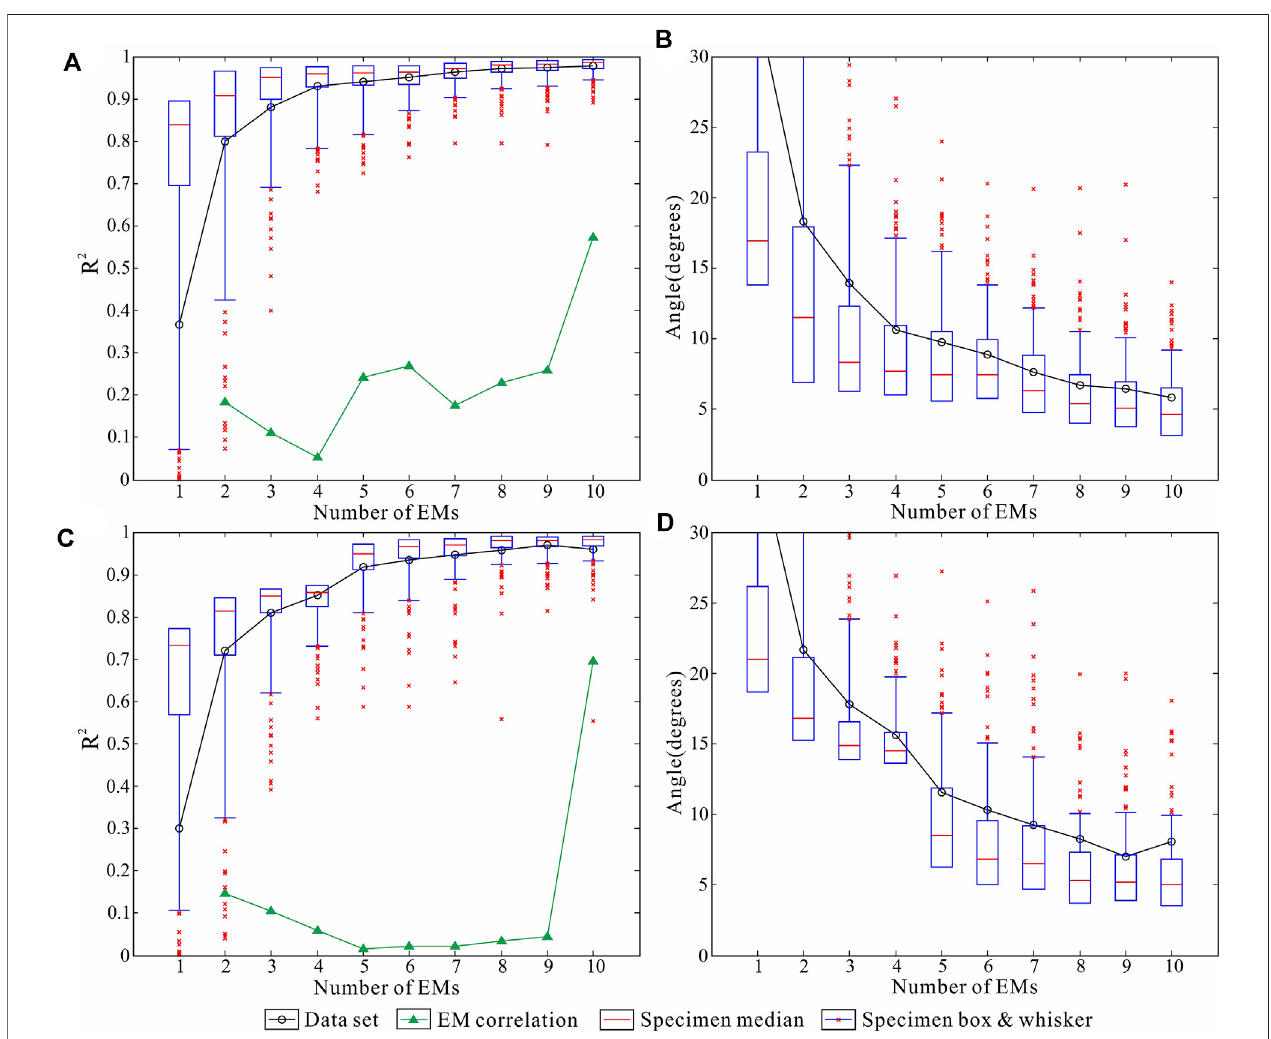
FIGURE5| Fittingeffectoftheend-memberanalysisofsurfacesedimentsinthestudyarea. (A) LinearandEMcorrelationoftheNEMA. (B) Angulardeviationofthe NEMA. (C) Linear and EM correlation of the PEMA. (D) Angular deviation of the PEMA.